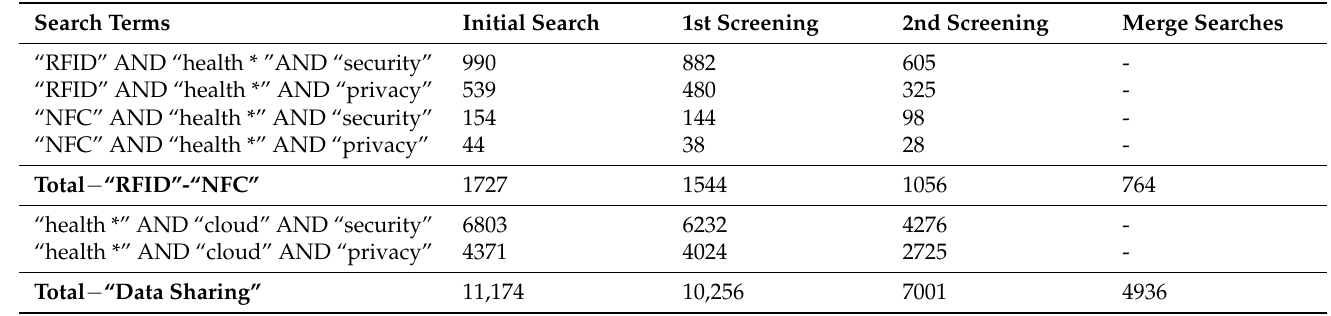
Table 1. Literature search regarding security and privacy in healthcare through NFC/RFID or data sharing architectures. The symbol “*” denotes that all the results including the given substring are